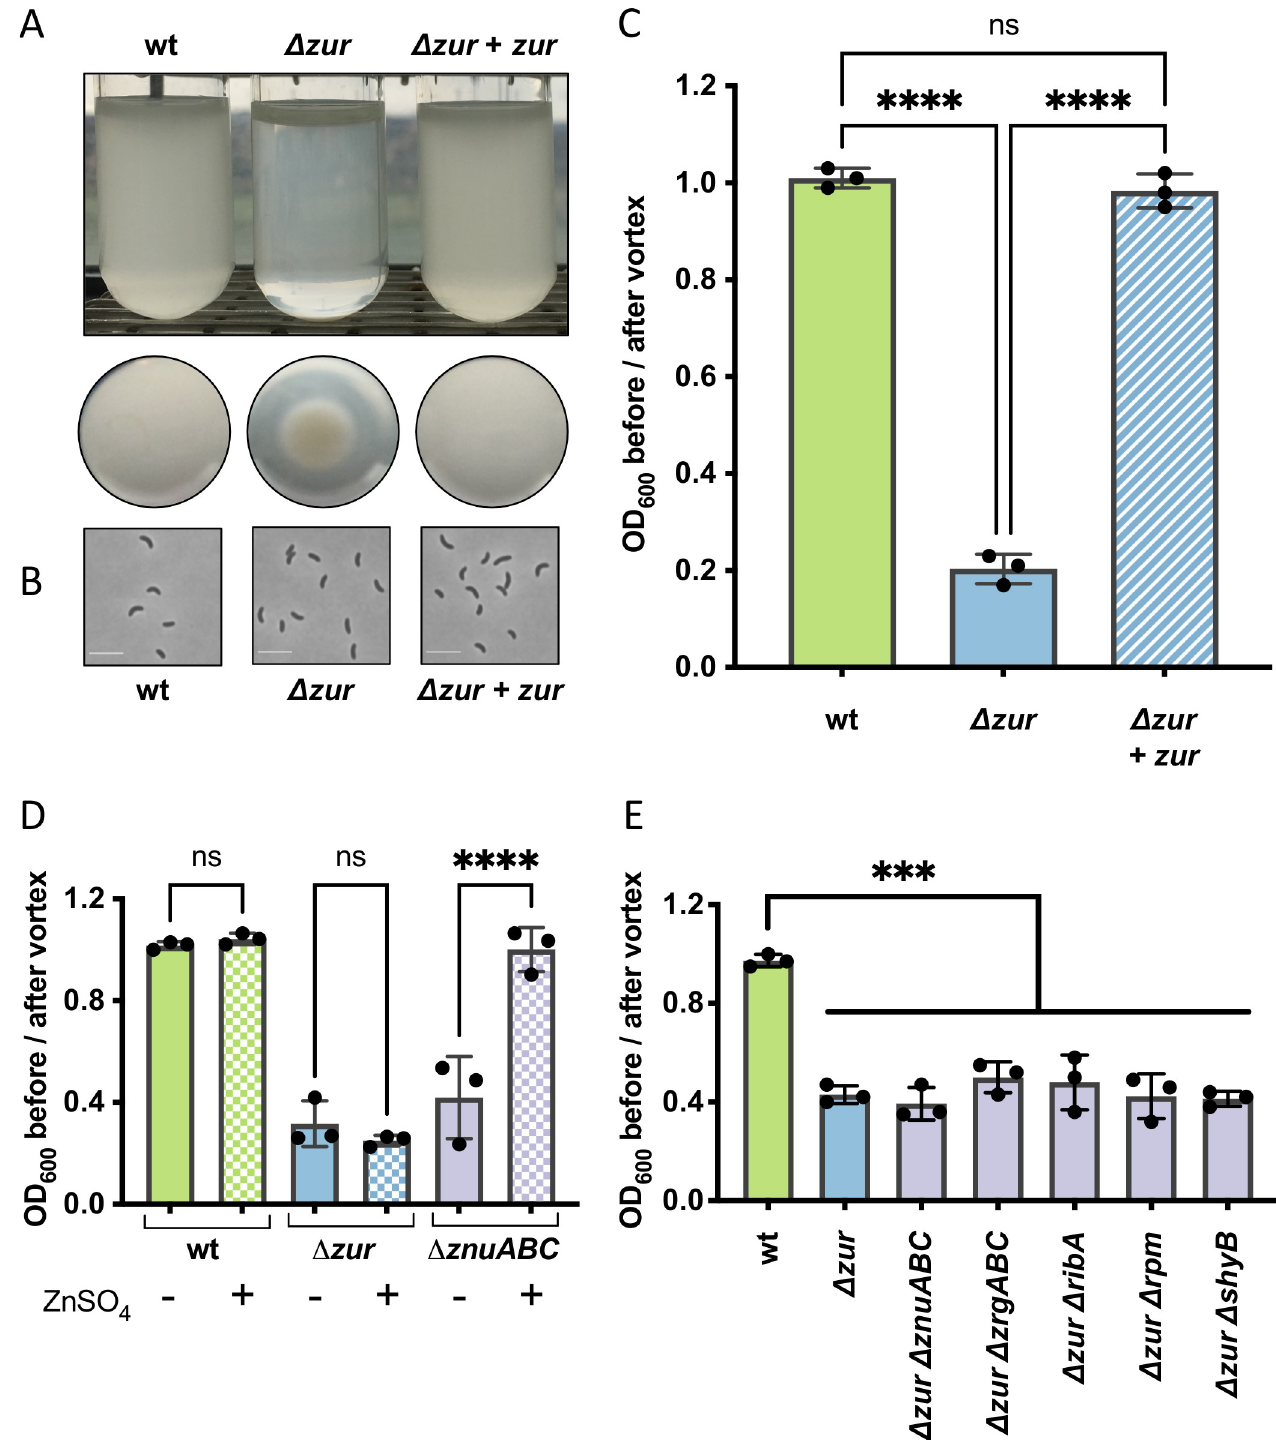
Fig 1. A V . cholerae Δ zur mutant congregates in M9 minimal medium. ( A-C ) Wild-type, Δ zur , and Δ zur carrying an integrated, IPTG-inducible copy of zur (denoted + zur ) were grown overnight at 30˚C in M9 minimal medium supplemented with glucose (0.2%) and inducer (IPTG, 500 μ M). ( A ) Representative side and bottom-view photos of overnight cultures are shown. ( B ) Cells collected from the bottom of the tube were imaged on an 0.8% agarose pad. Scale bar, 5 μ M. ( C ) Congregation was quantified by measuring the optical density (at 600 nm) of the culture supernatant before and after a brief vortex. A ratio close to 1 represents a homogenous culture, a ratio closer to 0 indicates congregation. ( D ) Congregation was measured in wild type, Δ zur , and a zinc importer mutant